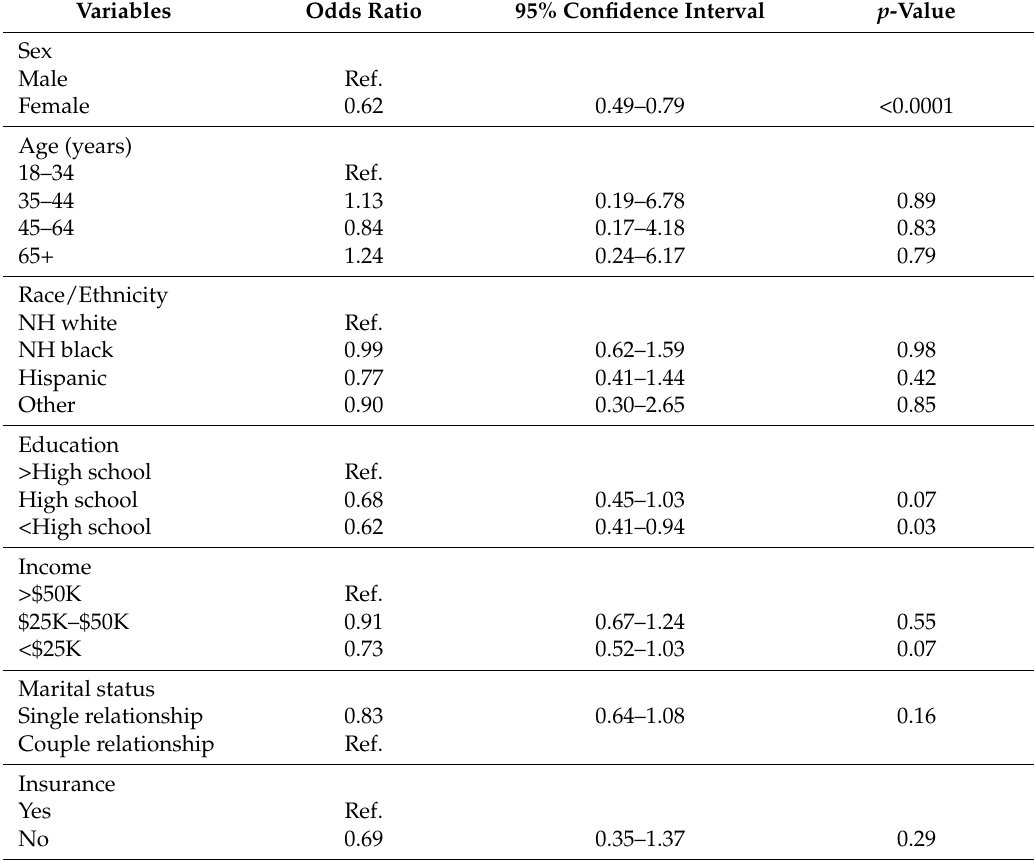
Table 4. Multivariate logistic regression analysis of factors associated with aspirin use among respondents based on CVD status: BRFSS 2015